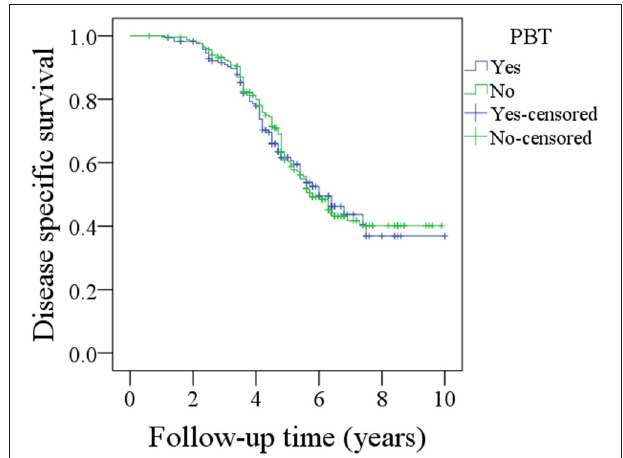
FIGURE 2 | Comparison of disease specific survival between patients with and without perioperative blood transfusion (PBT) ( p =